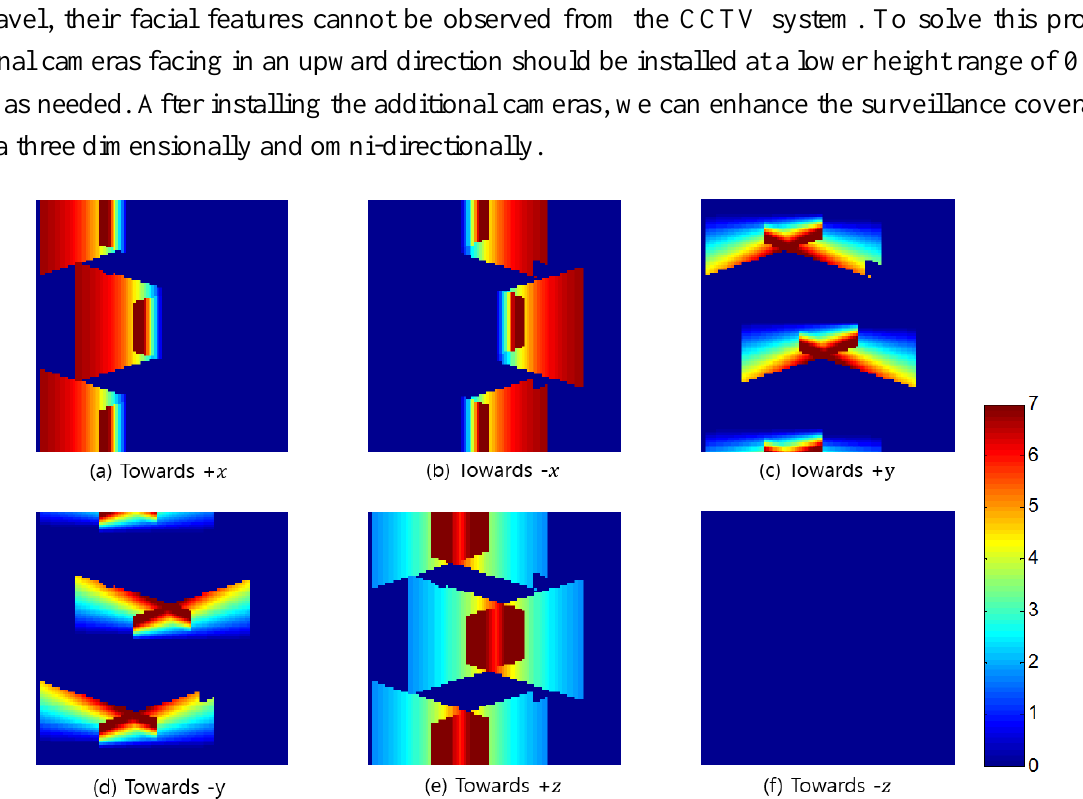
Figure 12. Surveillance resolutions according to the orientation (after adding a camera); ( a ) the resolutions with the +x direction; ( b ) the resolutions with the −x direction; ( c ) the resolutions with the +y direction; ( d ) the resolutions with the –y direction; the resolutions with the −x direction; ( e ) the resolutions with the +z direction; ( f ) the resolutions with the +z